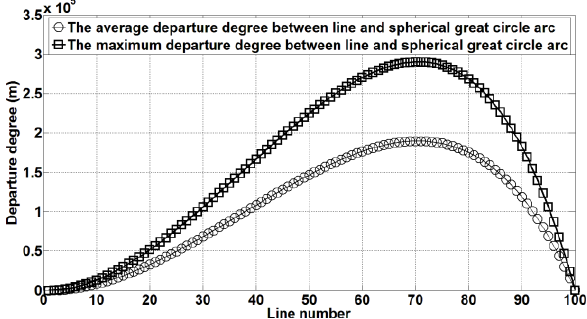
medial axes of the triangular facet.